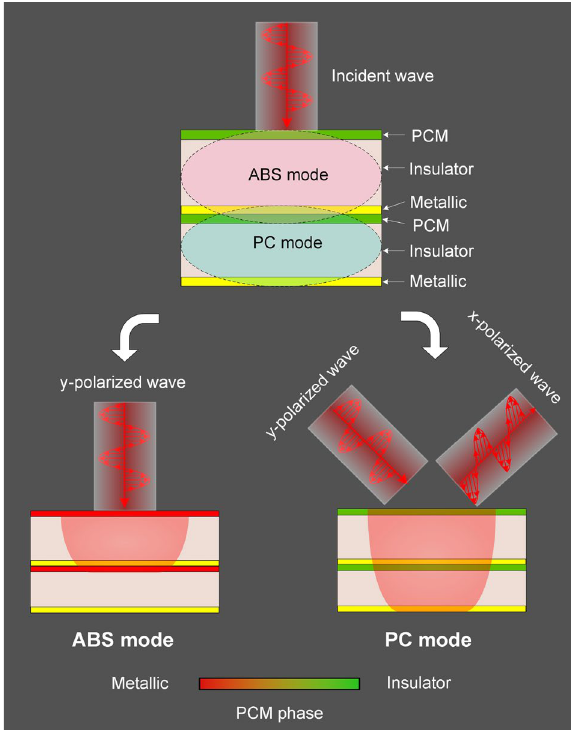
Figure 1. Design approach for RMSs with ABS and PC functions based on the reversible metallic-to-insulator phase transition of